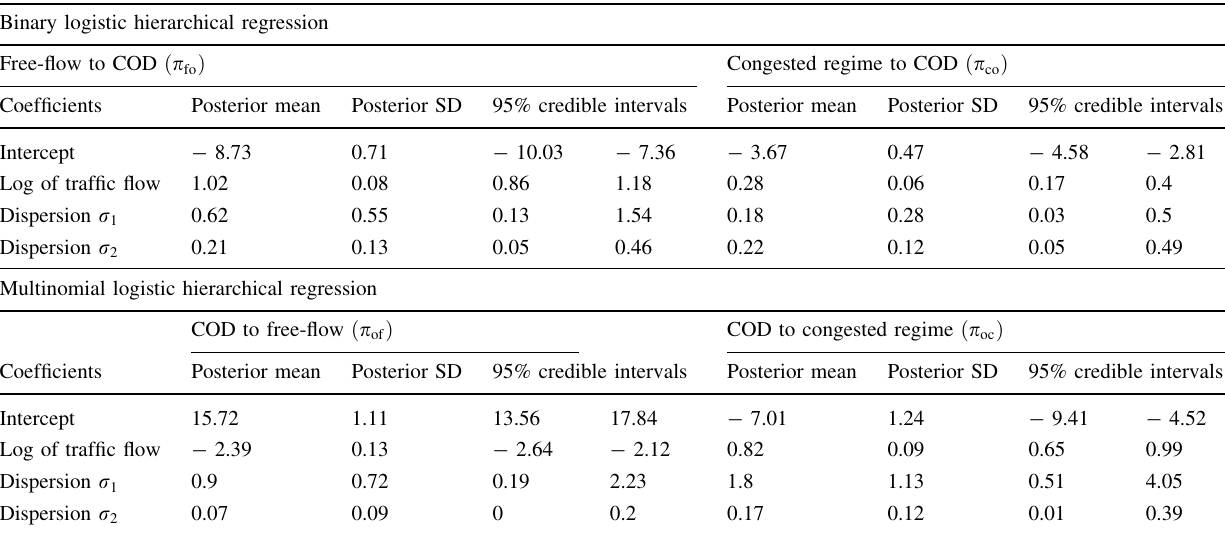
Table 3 Parameters posterior distributions summaries for Site 2 models Binary logistic hierarchical regression Free-flow to COD p fo